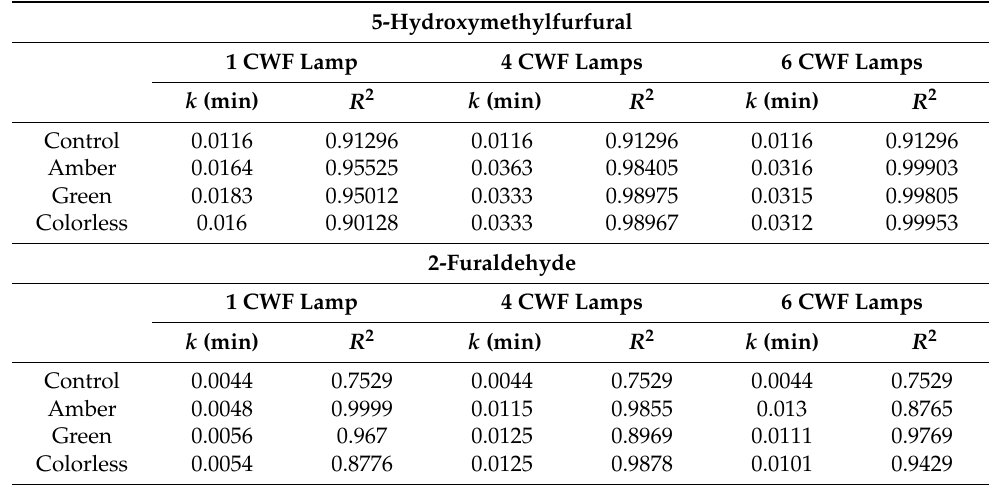
Table 4. Kinetics parameters for HMF and 2-furaldehyde formation in MdL stored in clear-colored glass bottles (amber, green, colorless) under different lighting condition (at constant temperature T = 25 ± 2 ◦ C). (Control was a sample kept in the